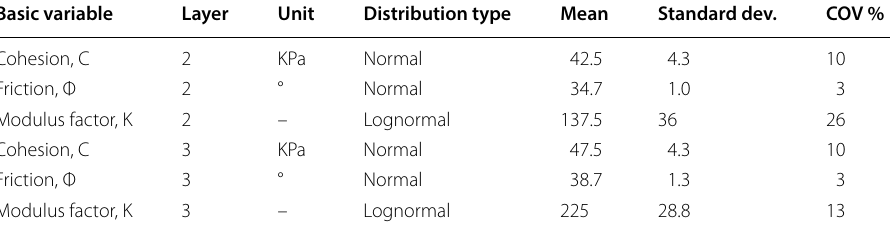
Table 6 Basic random variables and respective PDF details Basic